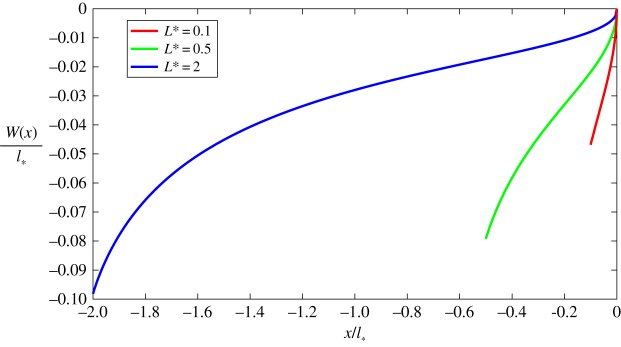
Jump of displacements for various L*.